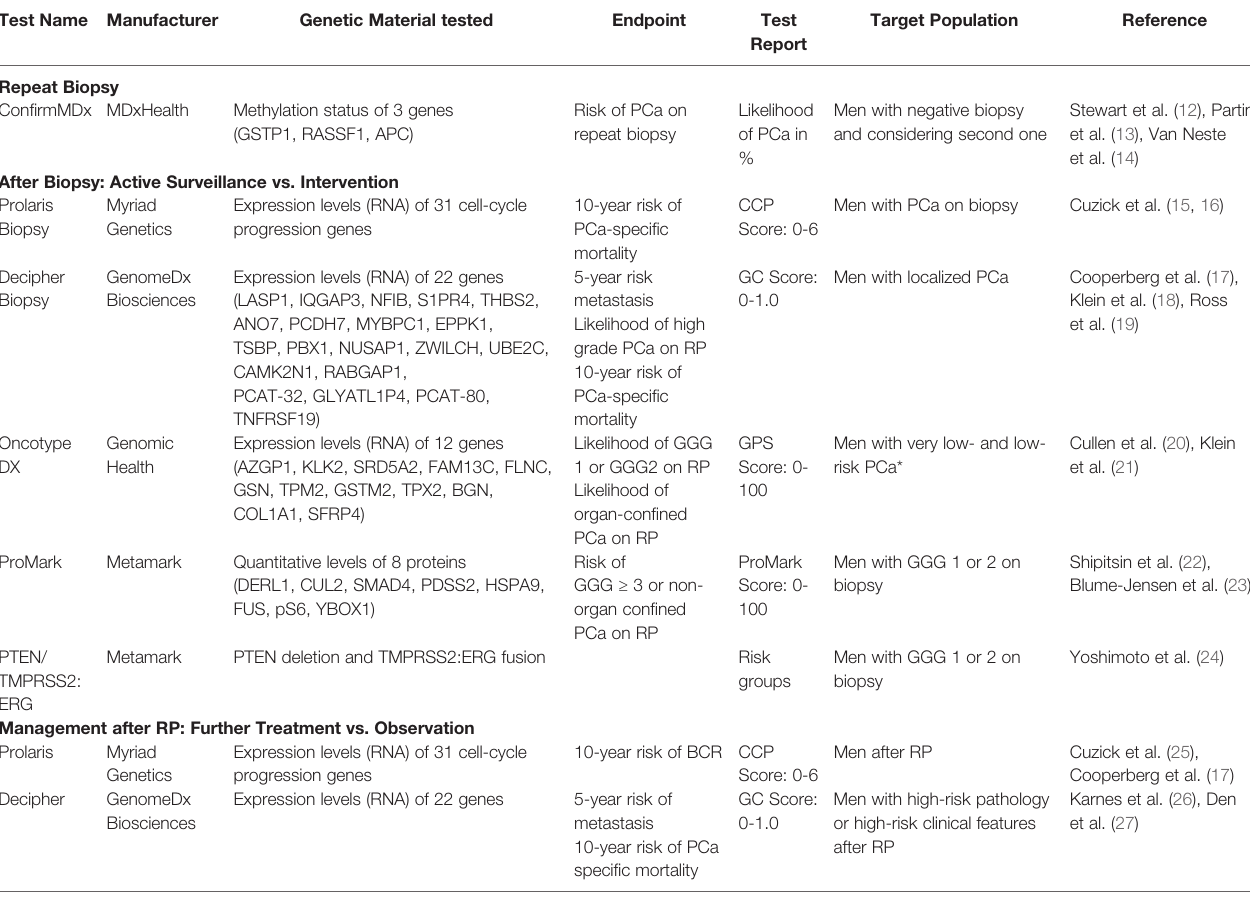
TABLE 1 | Summary of available tissue-based biomarkers and